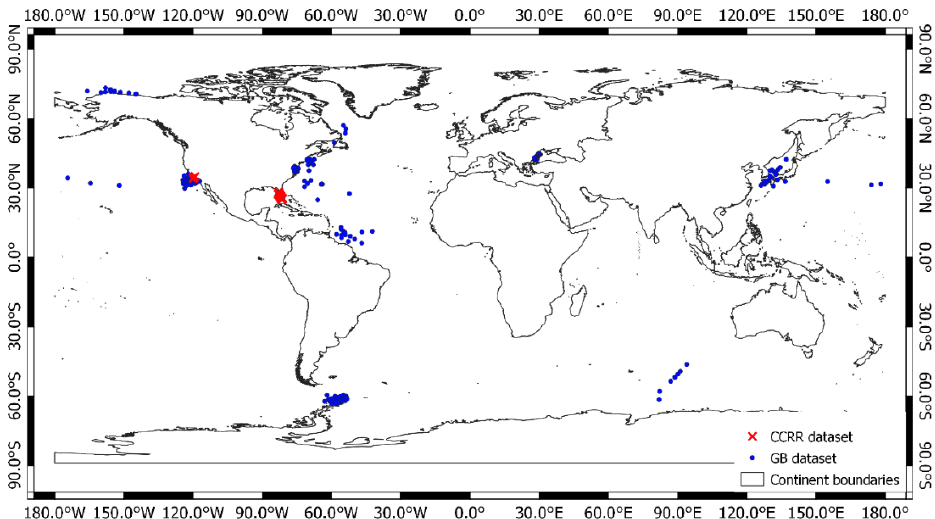
Figure 3. Locations of Stations in GB datasets (Blue Circles) and CCRR dataset (Red Cross).